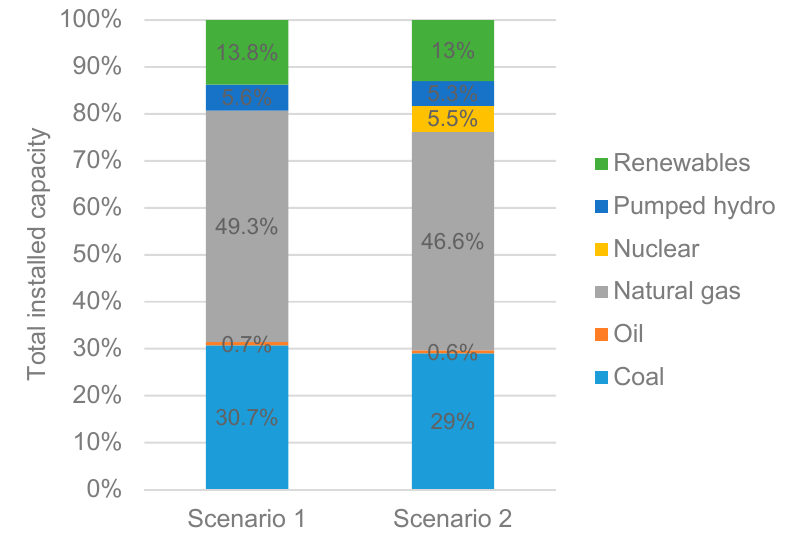
Figure 4. Baseline energy mix in 2025.